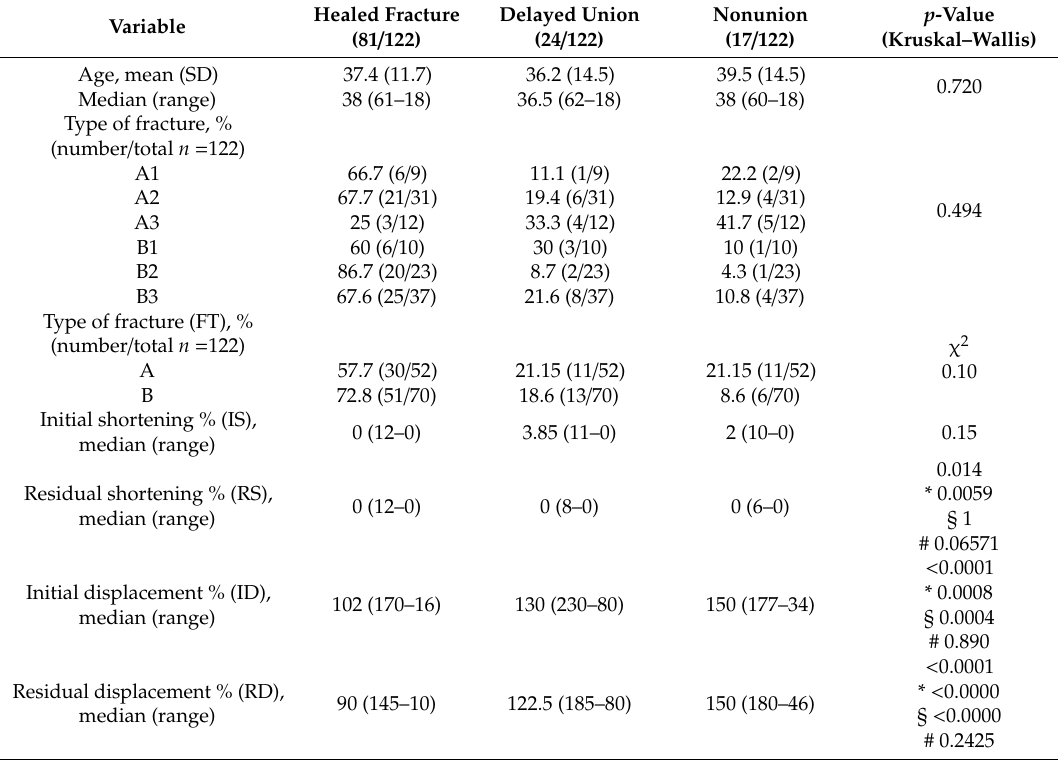
Table 2. Nonunion rate by type of fracture, amount of displacement and